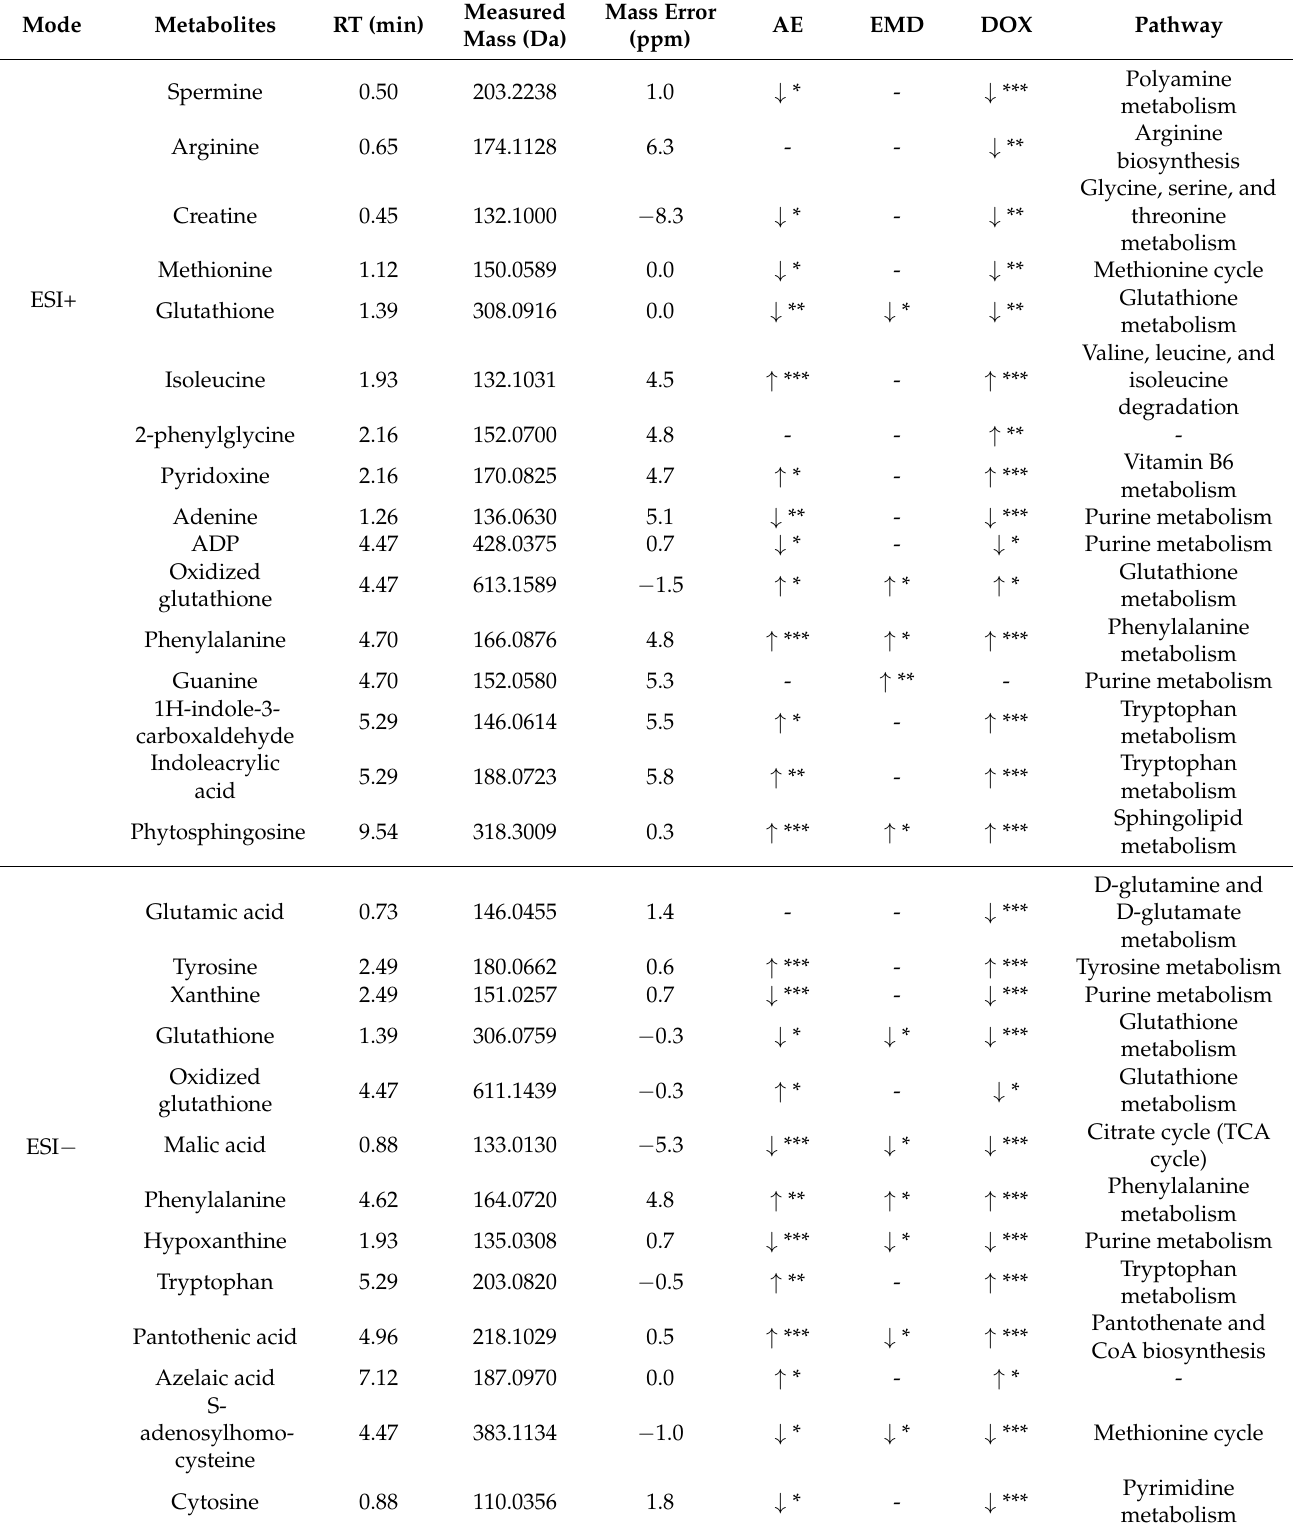
Table 1. Identification and change trend of